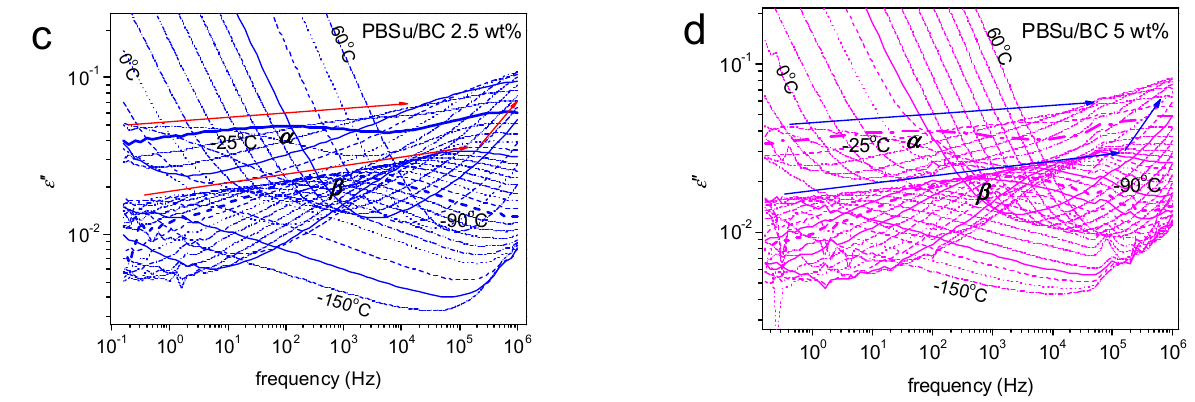
Figure 9. Comparative isothermal curves of the imaginary part of dielectric permittivity, ε″ (dielec- tric loss), against frequency for all samples indicated on the plots and temperatures. The evolution of the local β and segmental α relaxations are marked by the added arrows. The molecular dipolar relaxations are followed in these data as ‘peaks’ of the ε ″ ( f ), the maxima of which migrated at gradually increasing frequencies, f max , with the increase in temperature. This was due to the simultaneous lowering of the relaxation times ( τ rel ) of the corresponding molecular groups/chains. Two types of mobilities (peaks) are recorded for all samples, i.e., the local β process at the lower temperatures ( T < T g ) and the stronger segmental α process at T ≥ T g . To employ a more direct comparison with calorimetry, we replotted the isothermal data of Figure 9 and show them as comparative isochronal plots of ε ″ against temperature in Figure 10.